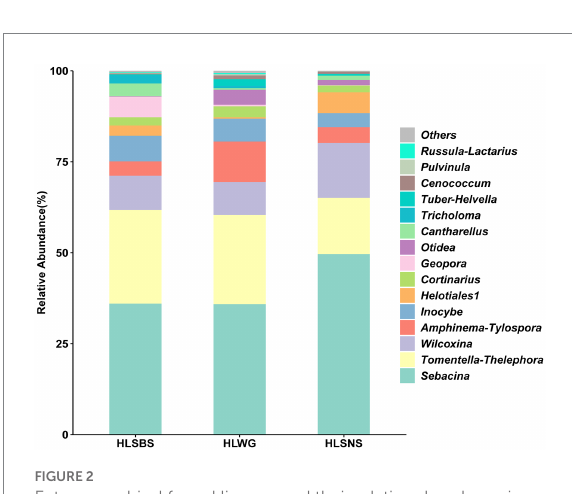
FIGURE 2 Ectomycorrhizal fungal lineage and their relative abundance in three sites. Here, we only showed the top 15 EM fungal lineages. HLSBS, HeLanShan-BeiSi; HLWG, HaLaWuGo; and HLSNS,